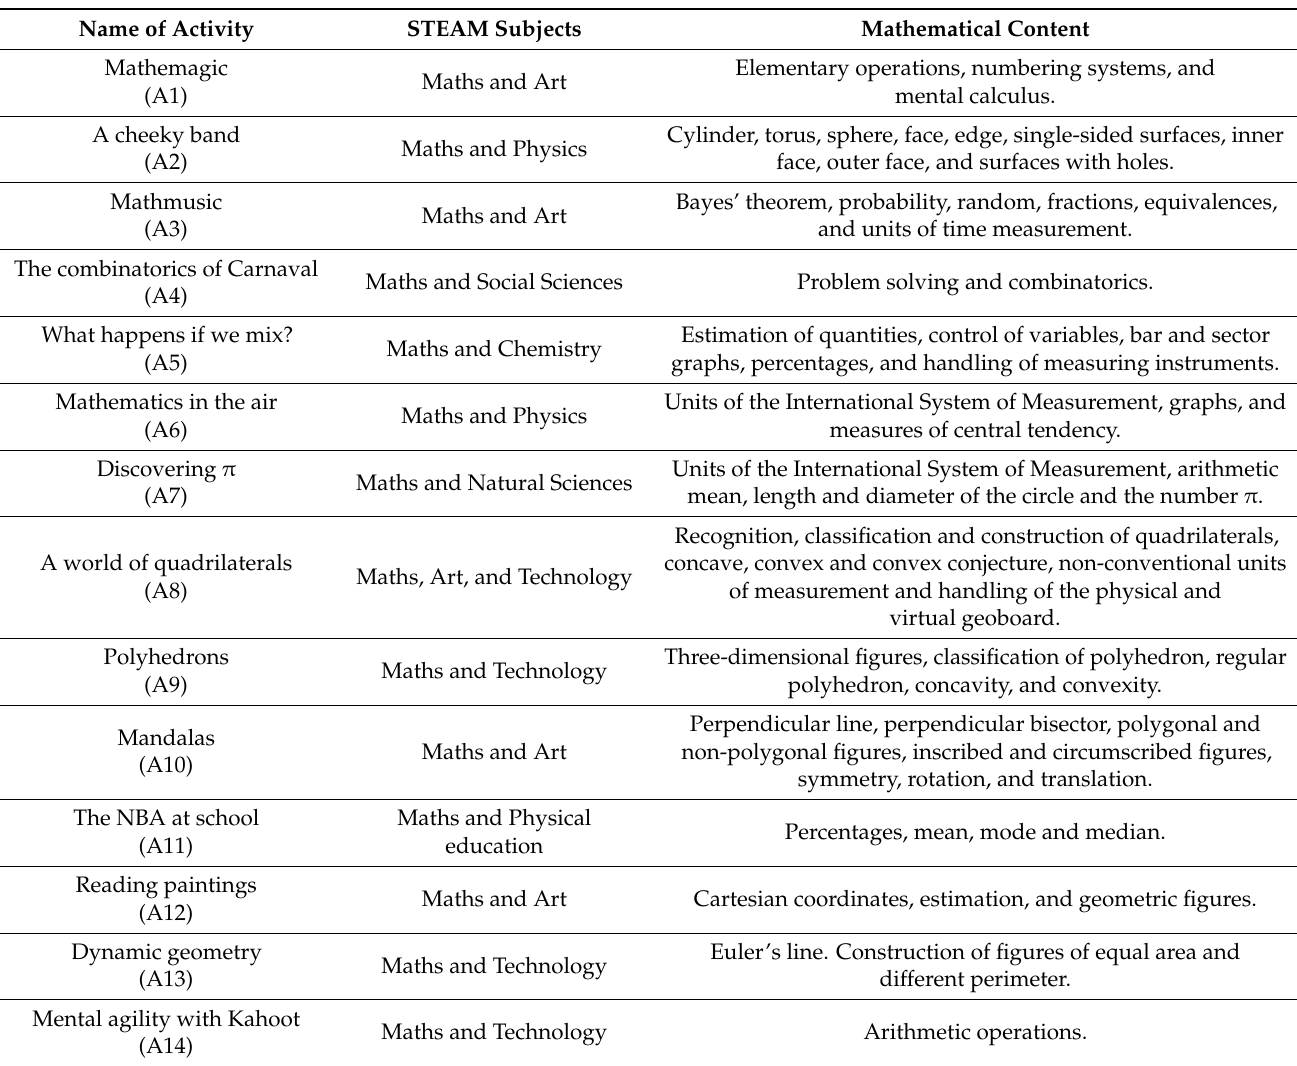
Table 2. Sessions of the Mathematical Bits program and disciplines that are worked on in each of the